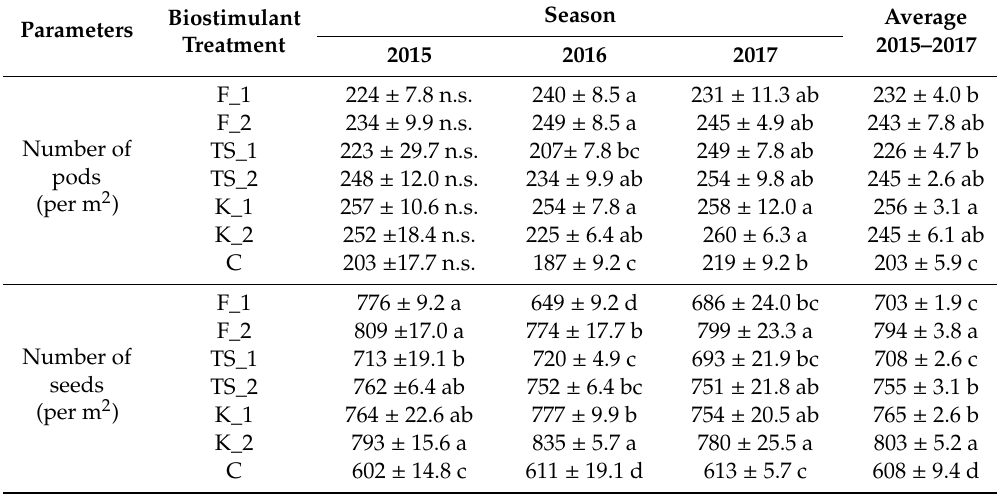
Table 4. E ff ect of Fylloton, Terra Sorb Complex, and Kelpak biostimulants treatment on number of pods and seeds of bean variety